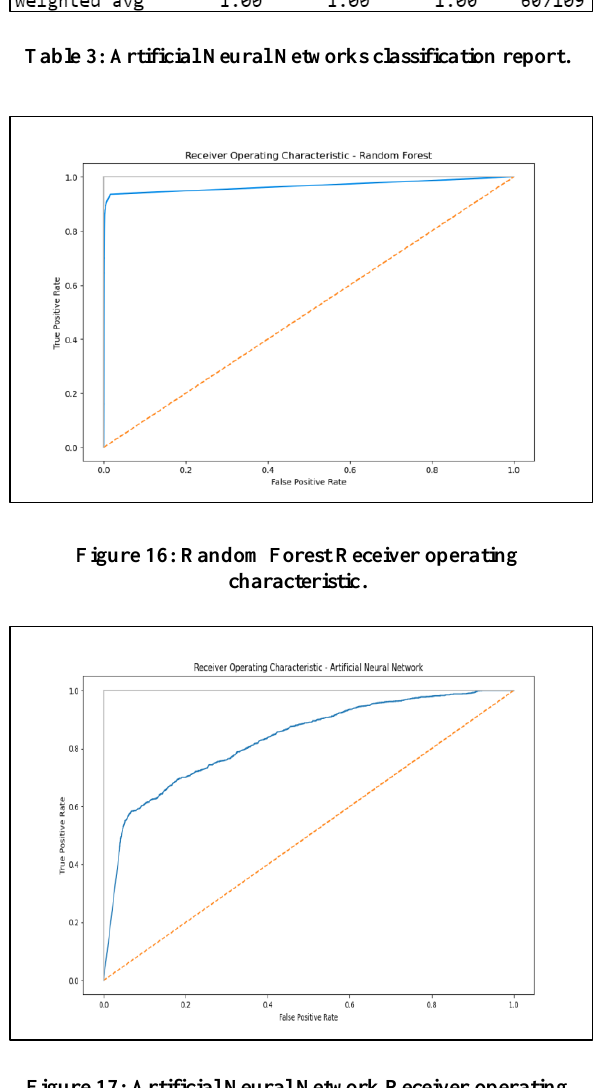
Figure 17: Artificial Neural Network Receiver operating characteristic.